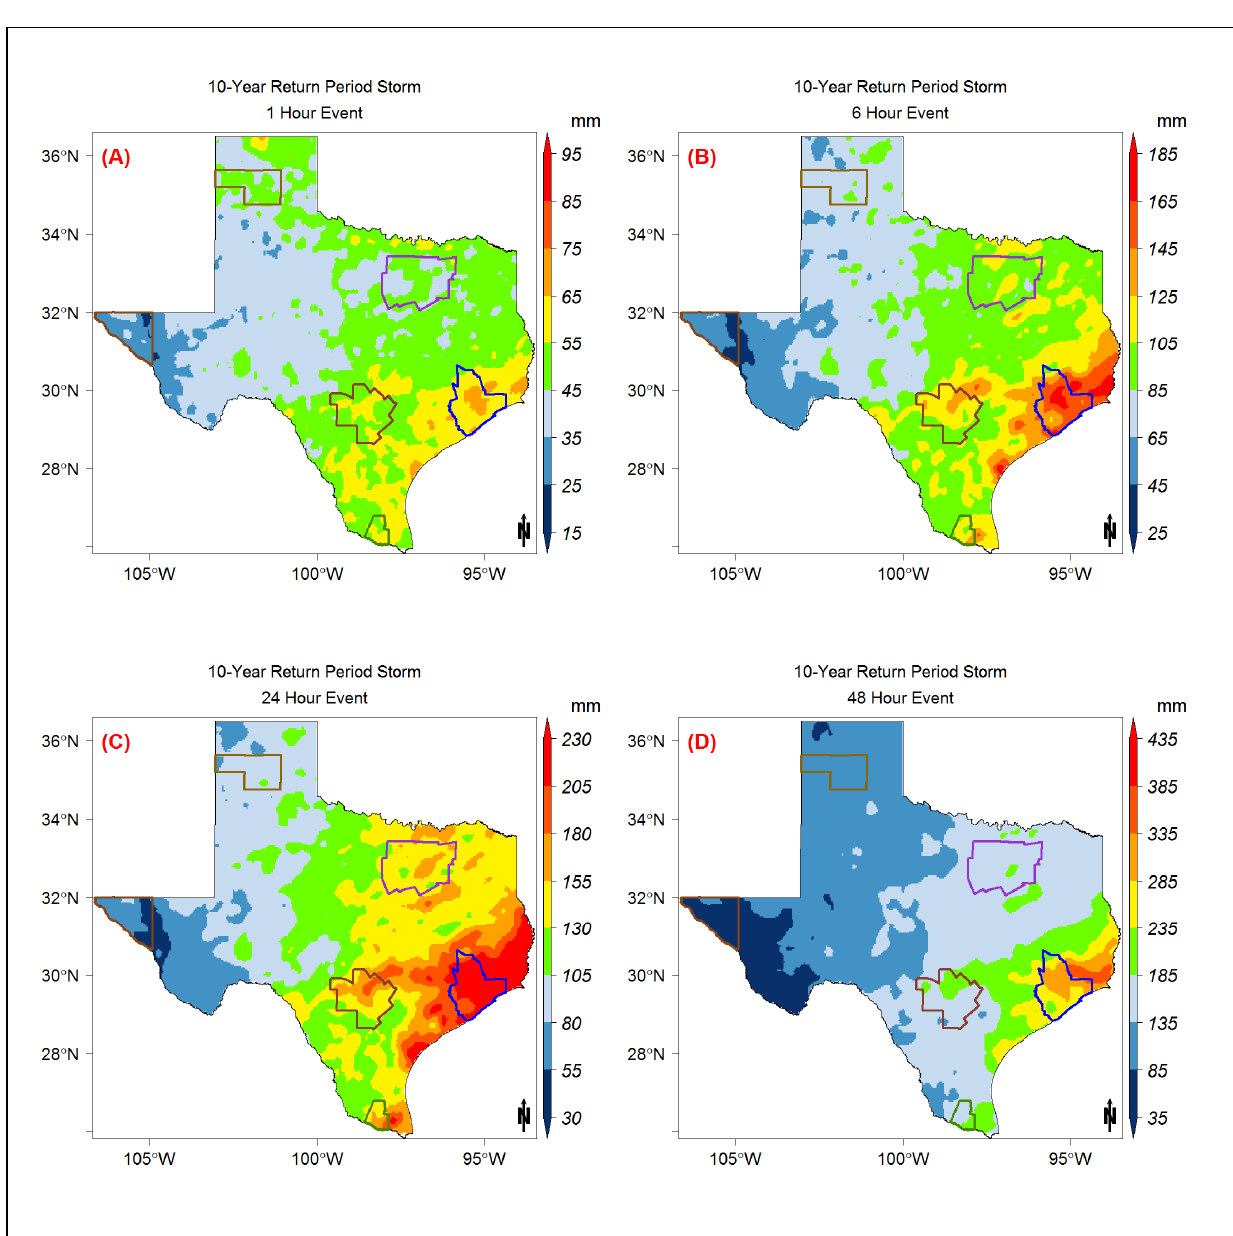
Figure A6. The 10-year return period storm event map modeled using the Gumbel model distribution for the ( A ) 1-h, ( B ) 6-h, ( C ) 24-h, and ( D ) 48-h storm durations.